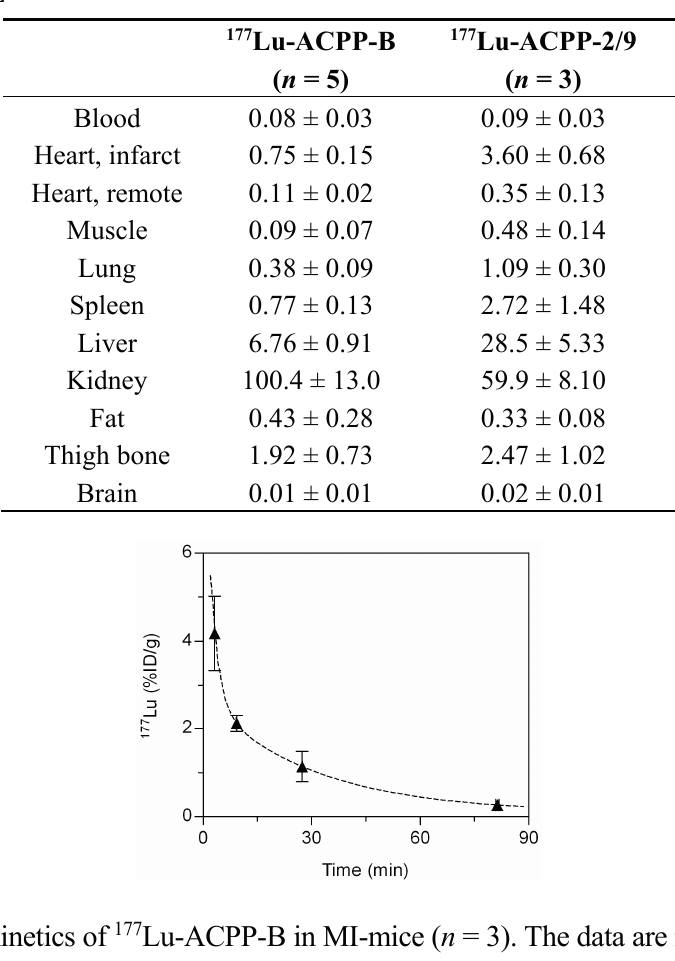
Table 1. Biodistribution results of 10 nmol 177 Lu-ACPP-B, and 177 Lu-ACPP-2/9 5 h post-injection in MI-mice. The data are mean %ID/g ± SD. Data for 177 Lu-ACPP-2/9 are reprinted from [1].